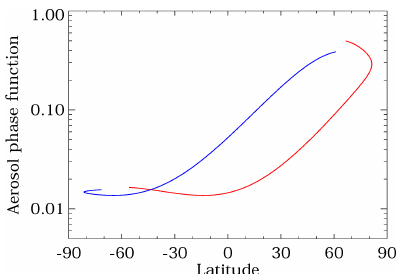
Figure 3. The aerosol phase function (for the (cid:50) values shown in Fig. 2) as a function of latitude for the SNPP OMPS LP instrument. June and December solstice conditions are illustrated by the red and blue lines, respectively. Due to the variation of the aerosol phase function with latitude and season, the SNPP OMPS LP observations are most sensitive to aerosols in the NH winter and least sensitive to those in the SH. The aerosol size distribution described in Table 1 for the V1 aerosol extinction retrieval algorithm is assumed.